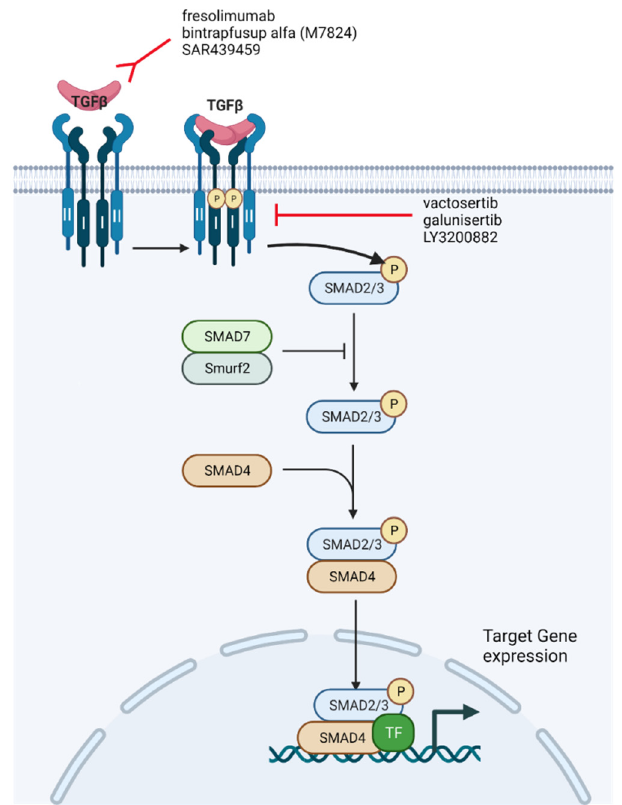
Figure 4. Current TGF- β signaling inhibitors being used in combination with ICI for human clinical trials (adapted from “TGF- β signaling”, by BioRender.com (2021). Retrieved from https://app.biorender.com/biorender-templates). Accessed 14 October 2021.